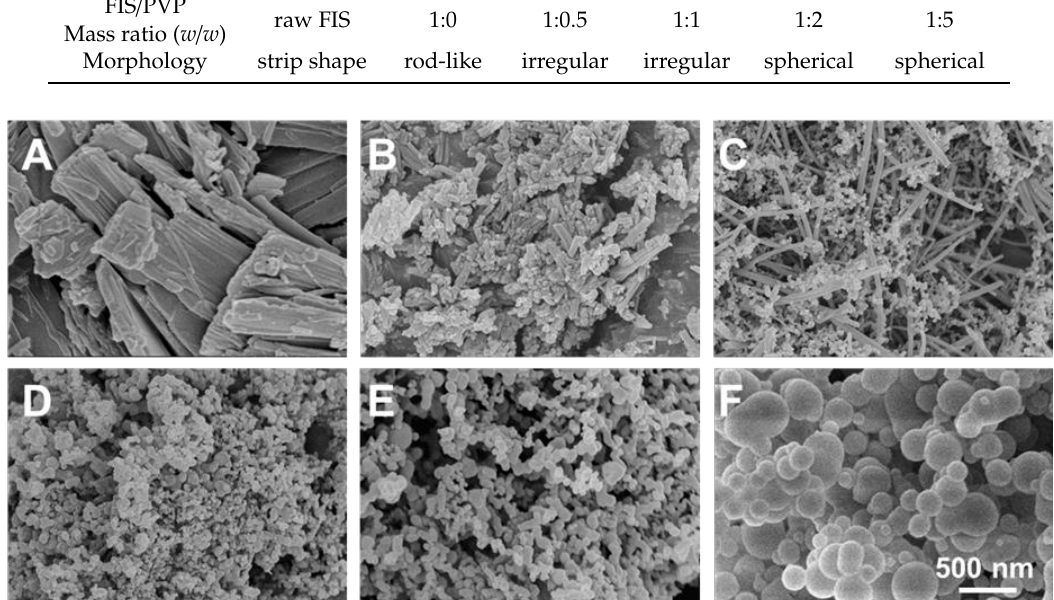
Figure 2. SEM photographs of ( A ) raw FIS, ( B ) SAS process-assisted FIS, and FIS-PVP particles at different FIS/PVP mass ratios ( w / w ) of ( C ) 1:0.5, ( D ) 1:1, ( E ) 1:2, and ( F ) 1:5.